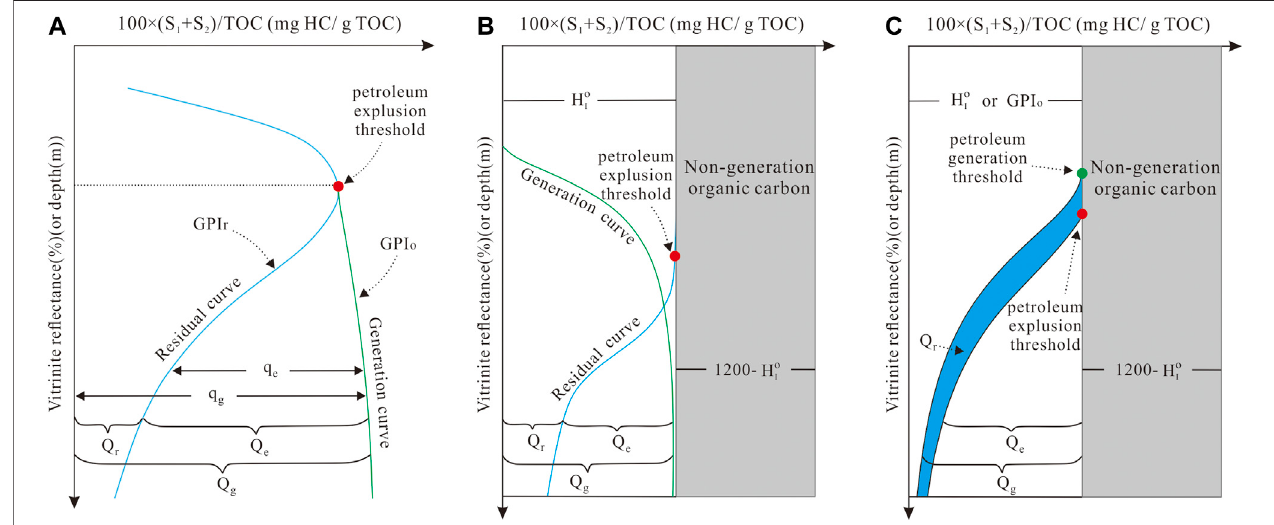
FIGURE4 | Hydrocarbon generationpotentialmodel ofrock pyrolysis. (A) Modi fi ed from Pang et al.,2005; (B) modi fi ed from Wang et al., 2020; (C) modi fi ed from Li C. R. et al., 2020.